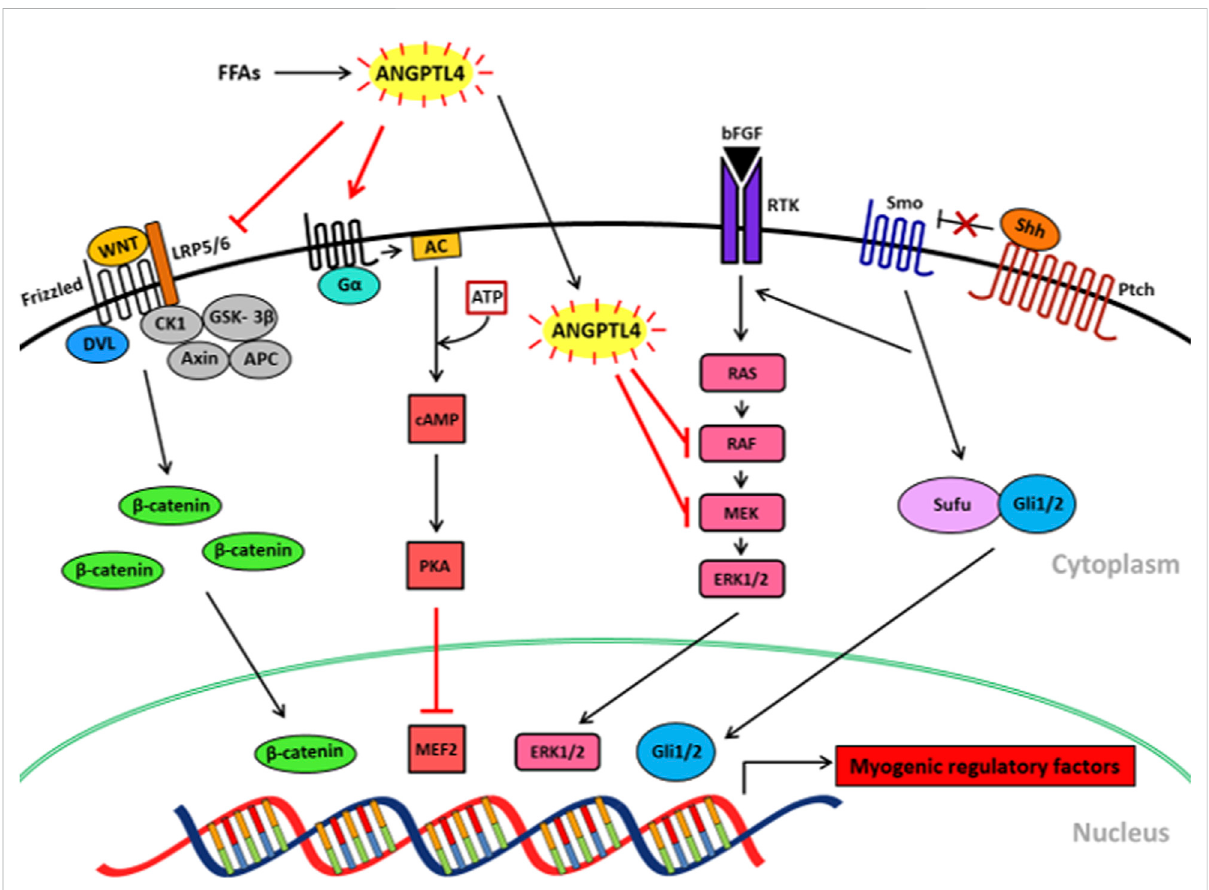
FIGURE 2 Proposed mechanisms of FFA-induced ANGPTL4 in skeletal muscle differentiation via signaling. FFAs induce ANGPTL4 release in skeletal muscle which downregulates Wnt/ β -catenin signaling by inhibiting LRP5/6 receptor binding to Wnt ligands. ANGPTL4 also inhibits bFGF-induced and Shh-induced MAPK/ERK signaling pathways by blocking the phosphorylation of RAF and MEK. ANGPTL4 stimulates cAMP/PKA signaling, resulting in the inactivation of MEF2. Those effects of ANGPTL4 on the signaling pathways may result in the inhibition of skeletal muscle differentiation. FFAs, free fatty acids; ANGPTL4, angiopoietin protein like 4; LRP5/6, low-density lipoprotein receptor-related protein 5/6; DVL, dishevelled; CK1, casein kinase 1; GSK-3 β , glycogen synthase kinase -3 β ; APC, adenomatous polyposis coli; PKA, cAMP-dependent protein kinase; MEF2,myocyteenhancerfactor2;AC,adenylatecyclase;bFGF,basic fi broblastgrowth factor; RTK,areceptortyrosinekinase;Shh,sonichedgehog; Ptch, patched; Sufu, surppressor of fused; Gli, glioma-associated